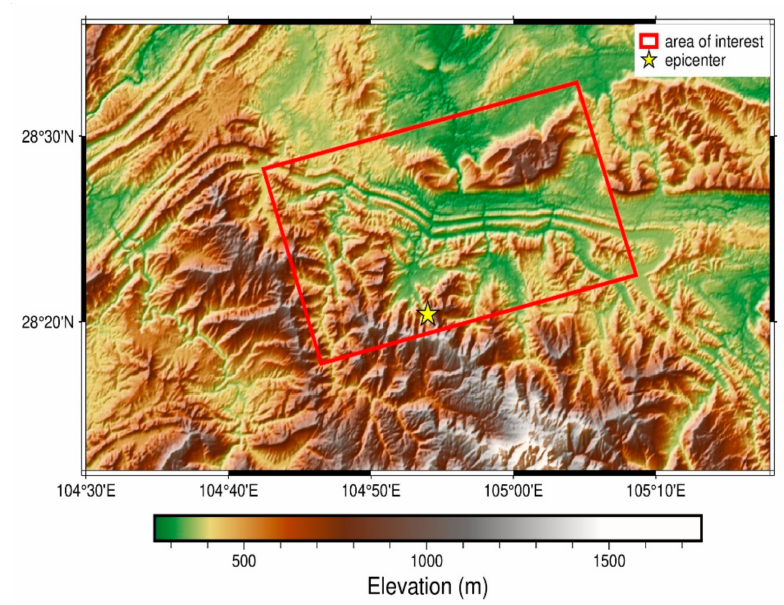
Figure 1. The range of the area of interest and the topography from SRTM3 v4.1 DEM [31]. The red rectangular represents the area of interest, the yellow pentagram represents the earthquake location as identified by the China Earthquake Networks Center. The color-coded strip represents the elevation of the